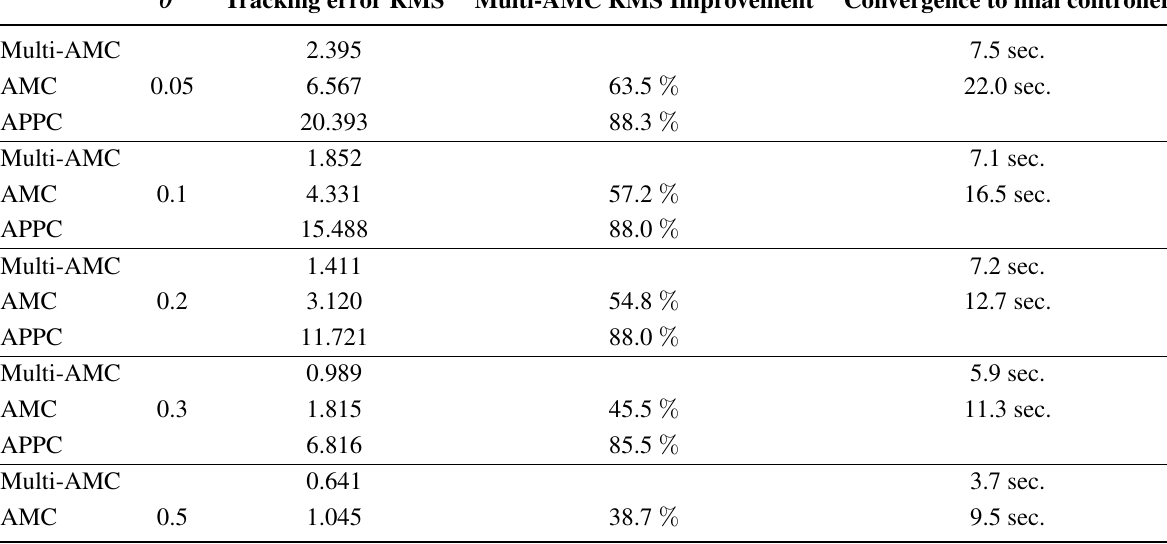
Table 2. Simulation results: tracking, ideal case, non-zero initial